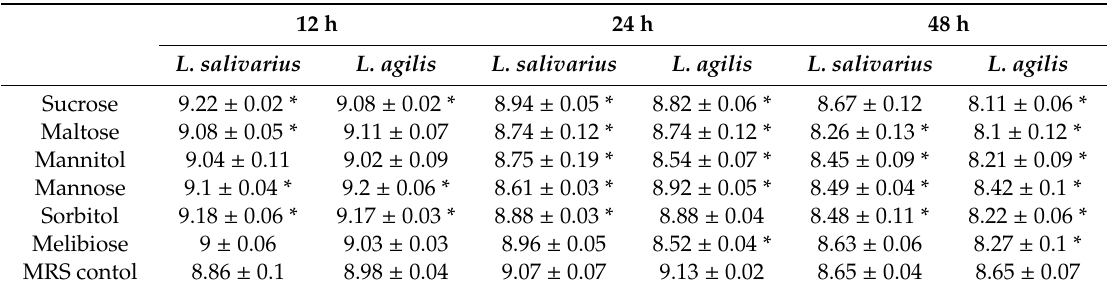
Table 1. Biomass of the probiotic strains in media supplemented with di ff erent additional substrates at di ff erent time points [log CFU /